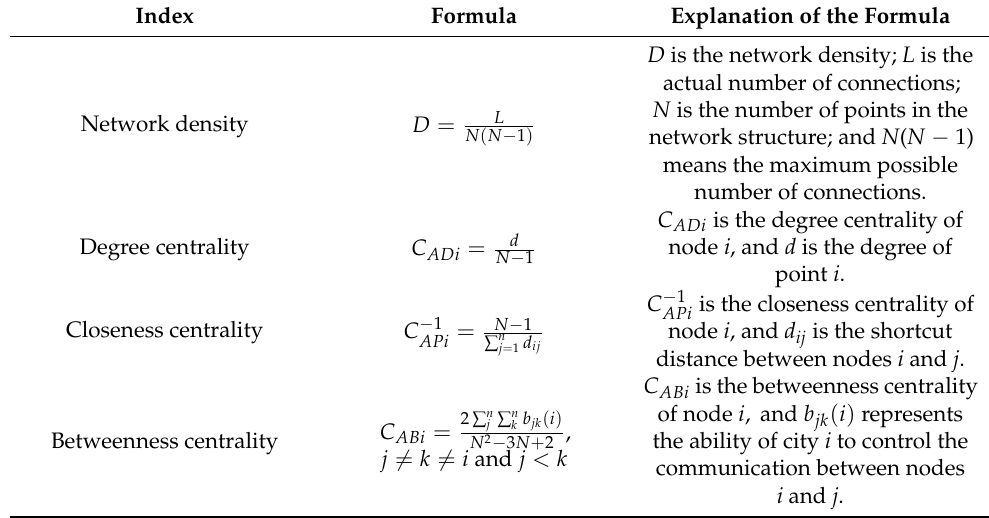
communication between nodes i and j